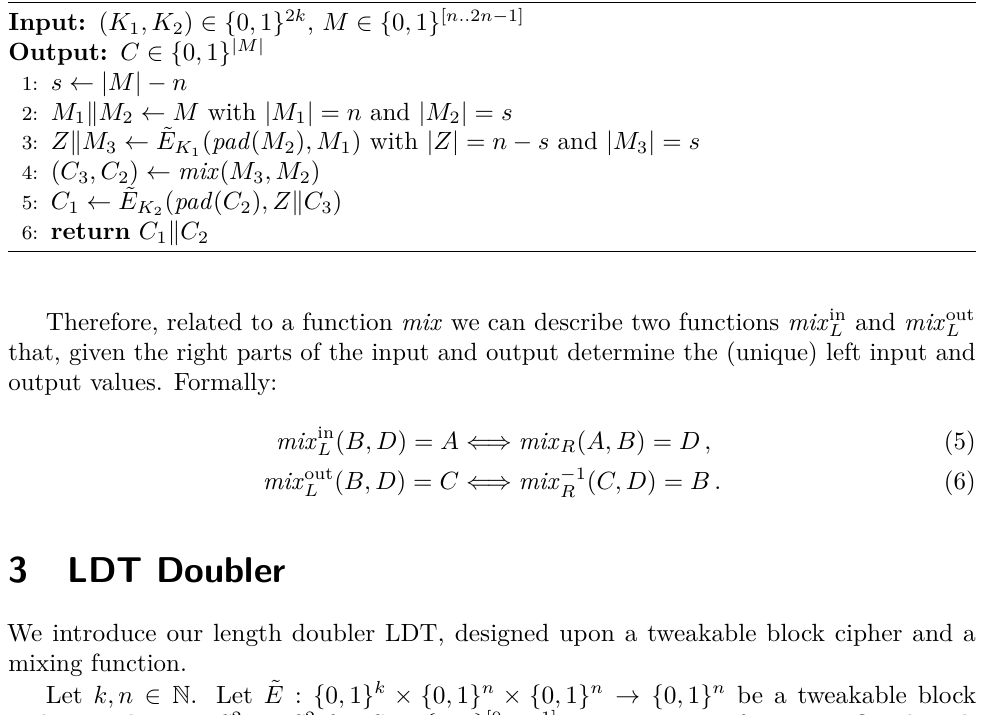
Algorithm 1 E = LDT[ ˜ E, mix ]